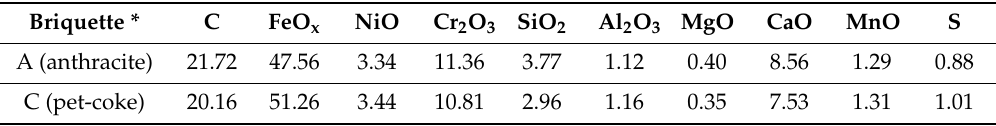
Table 1. Average chemical compositions of di ff erent industrial briquettes (in